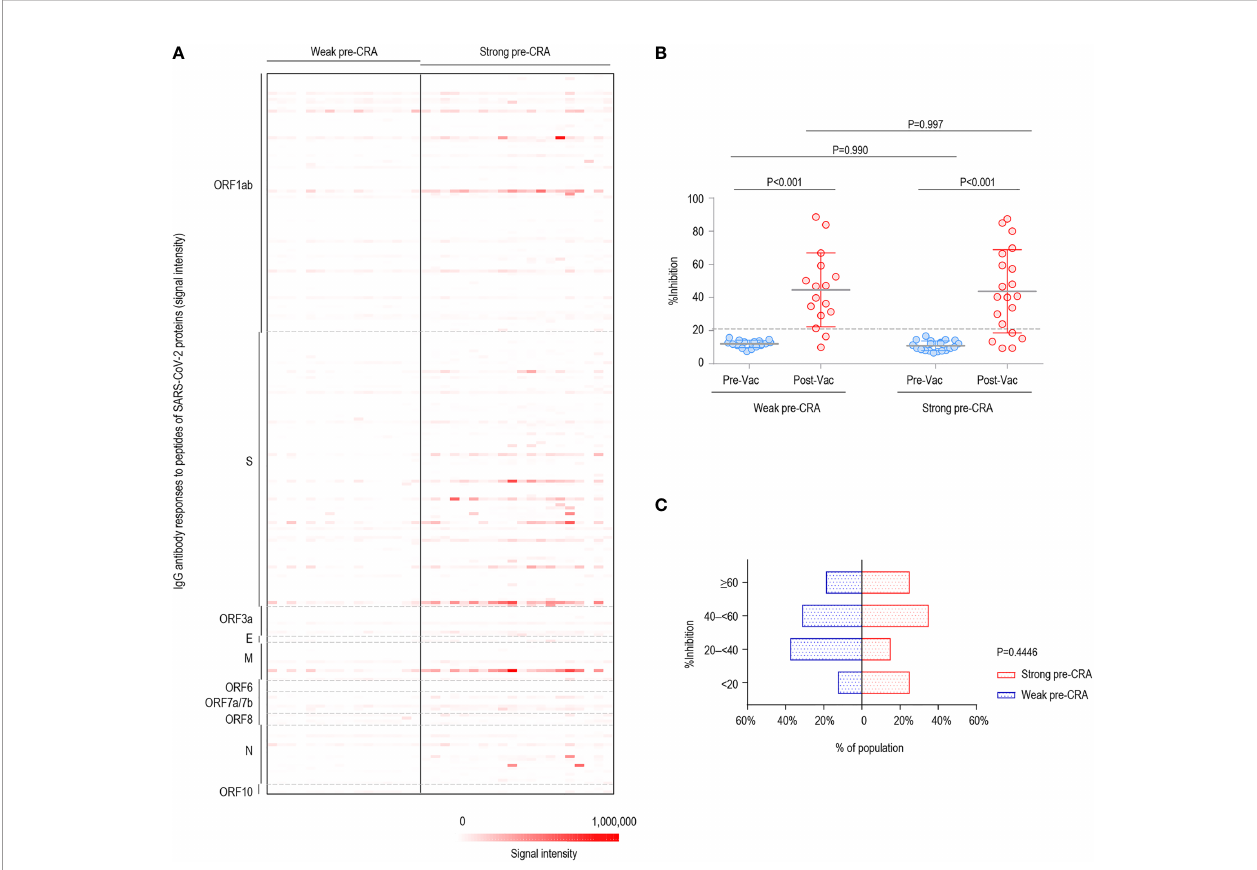
FIGURE 3 | The impact of pre-existing cross-reactive antibodies on inactivated COVID-19 vaccine-induced neutralization. The participants were divided into two groups with strong and weak pre-existing cross-reactive antibodies (Strong pre-CRA, n=20; Weak pre-CRA, n=16). The individuals with a stronger pre-existing antibody response were de fi ned as those having more than fi ve reactive peptides, against which IgG signal intensities exceeded mean + 2 SD readings. (A) The strong pre-CRA group had stronger fl uorescence intensities, indicating higher levels of pre-existing antibodies. (B) The %inhibition between the strong pre-CRA and weak pre-CRA groups. (C) The proportions of participants with %inhibition <20%, 20% to <40%, 40% to <60% and ≥ 60% in the strong pre-CRA and weak pre- CRA groups. Pre-Vac, pre-vaccination; Post-Vac,